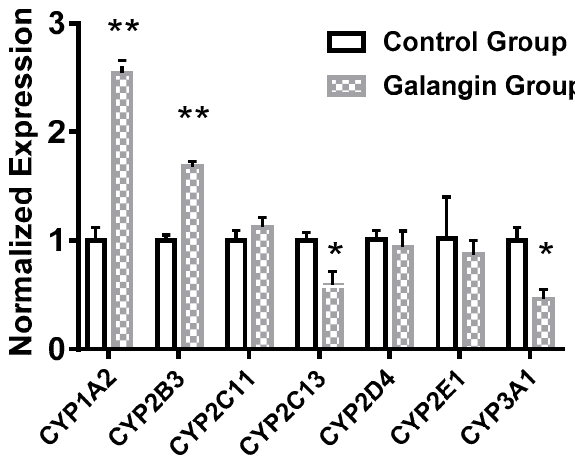
Figure 4. Effect of galangin on mRNA expression of CYP450 in rats ( n = 4). * p < 0.05 versus control, ** p < 0.01 versus control.